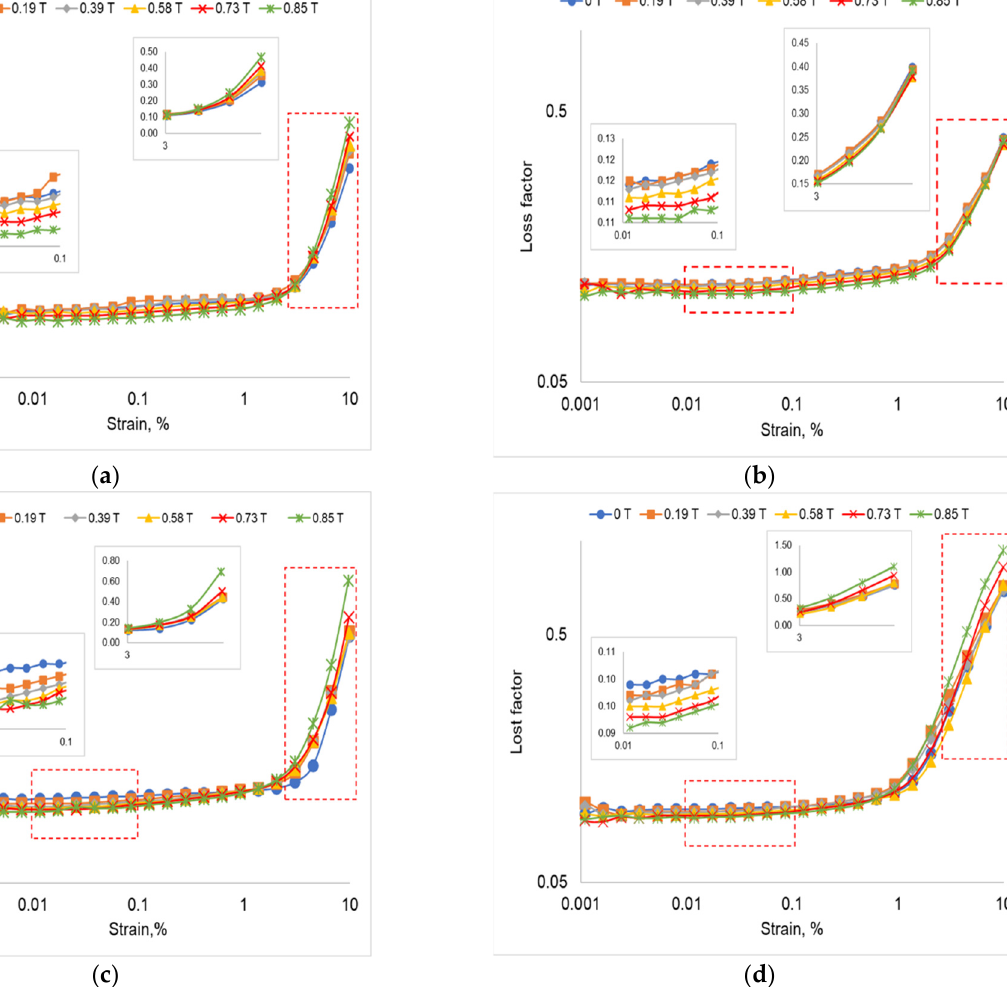
Figure 3. The loss factor of SR-MRE samples with 30 wt% of CIPs ( a ) before and ( b ) after thermal aging, and SR-MRE samples with 60 wt% of CIPs ( c ) before and ( d ) after thermal aging under various magnetic flux densities.